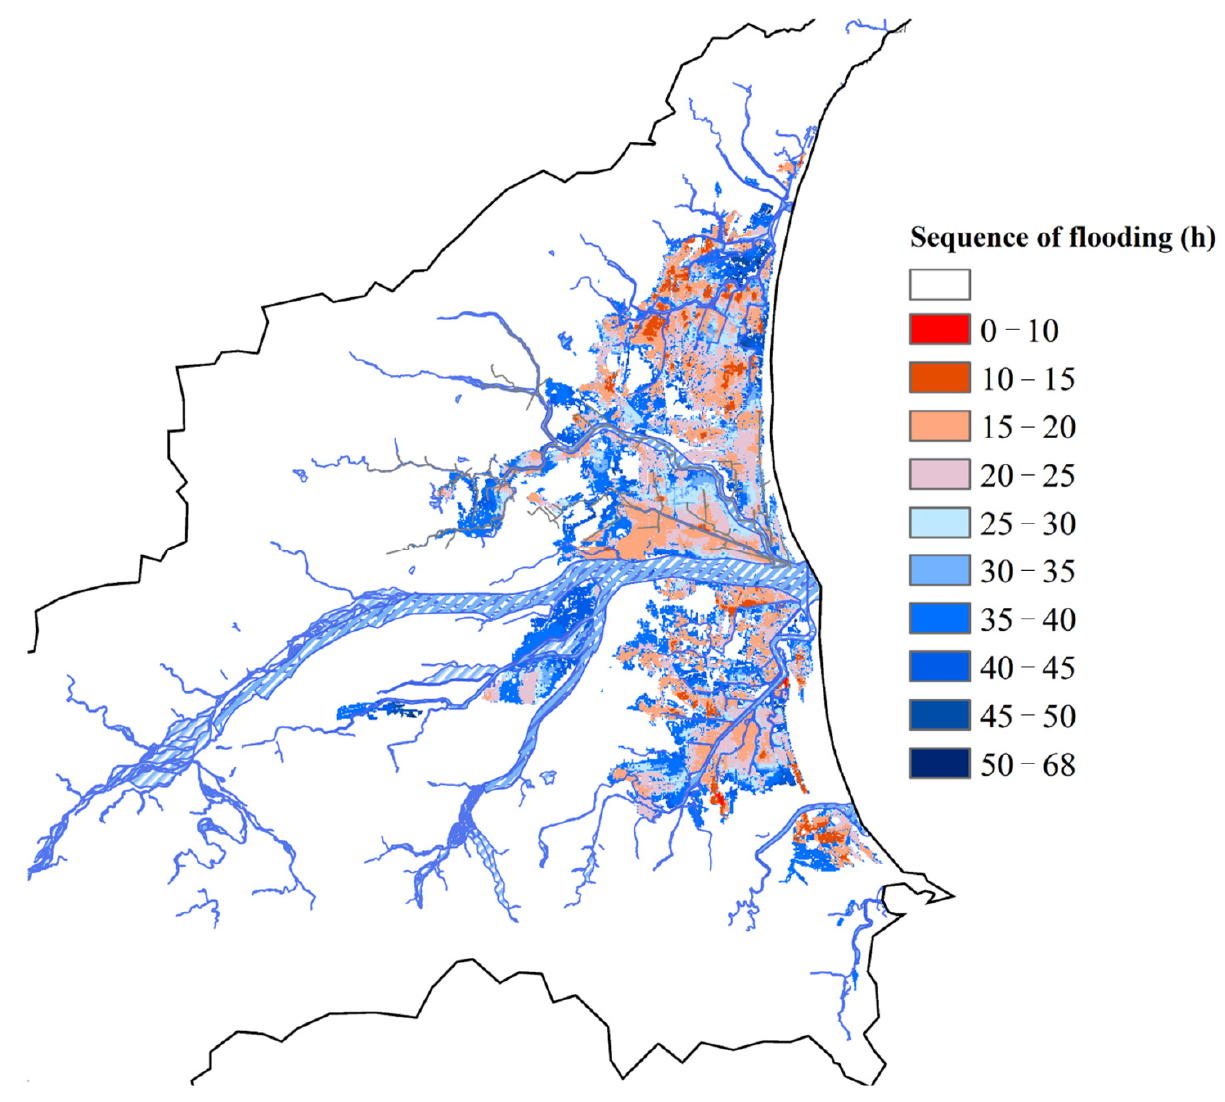
Figure 4. The order in which flooding